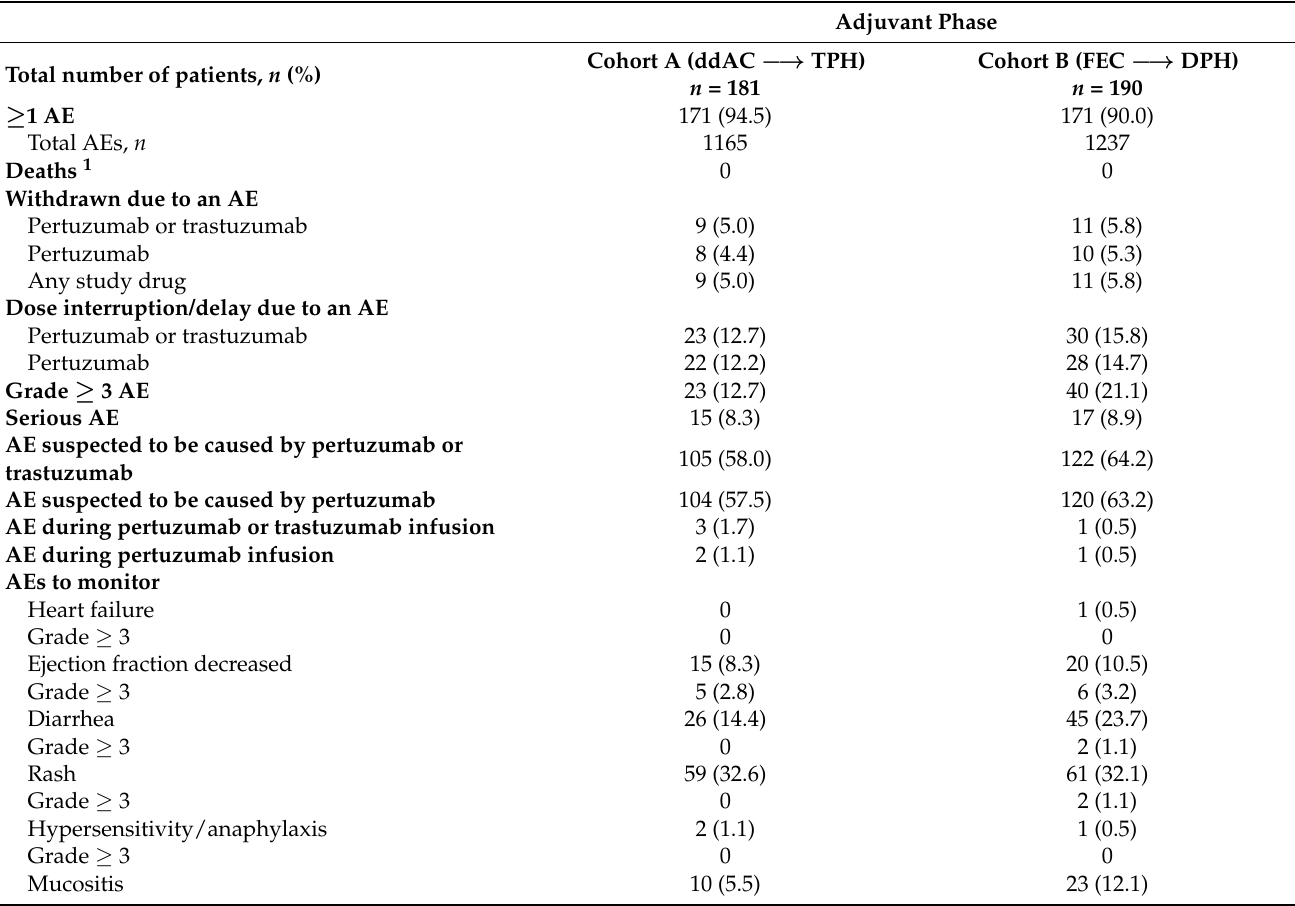
Table 2. AEs during the adjuvant